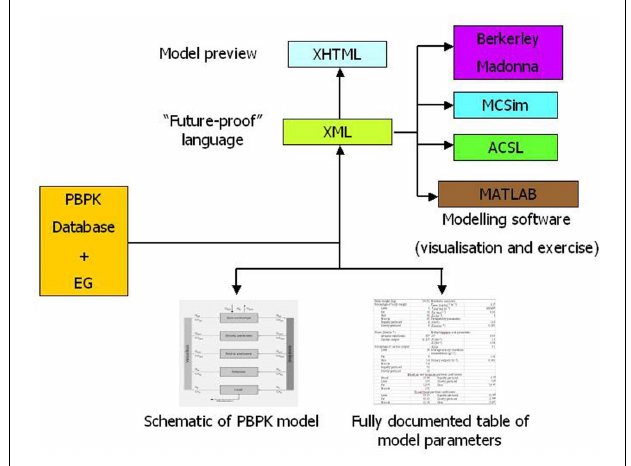
FIGURE 1 | MEGen components and